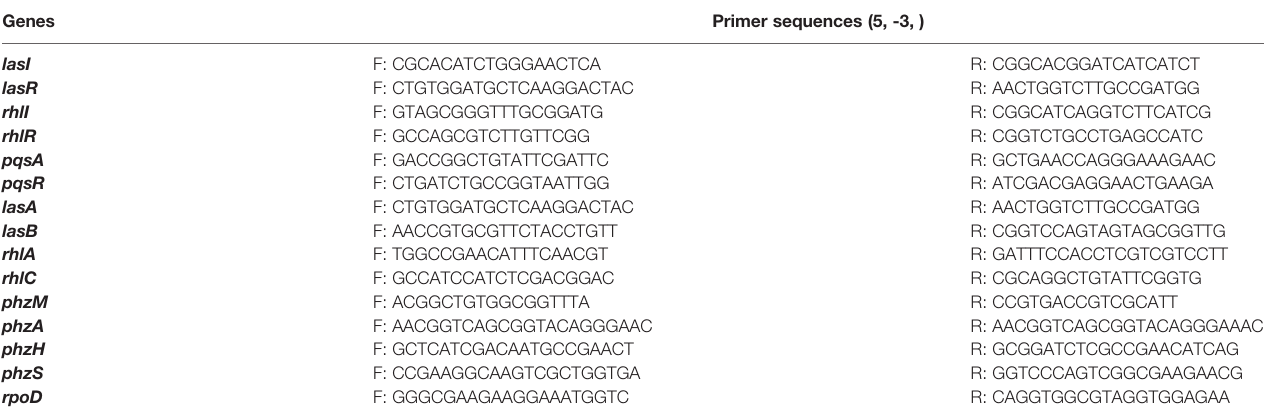
TABLE 1 | qPCR primers of P. aeruginosa for analysis of gene expression. Genes Primer sequences (5, -3,